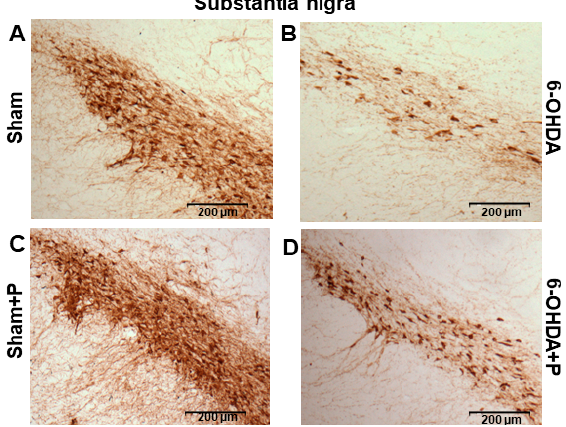
Figure 8. Representative SNc images of TH-immunoreactive sections. TH-positive dopaminergic neurons in the SNc in ( A ) sham; ( B ) 6-OHDA; ( C ) sham+P; ( D ) 6-OHDA+P.